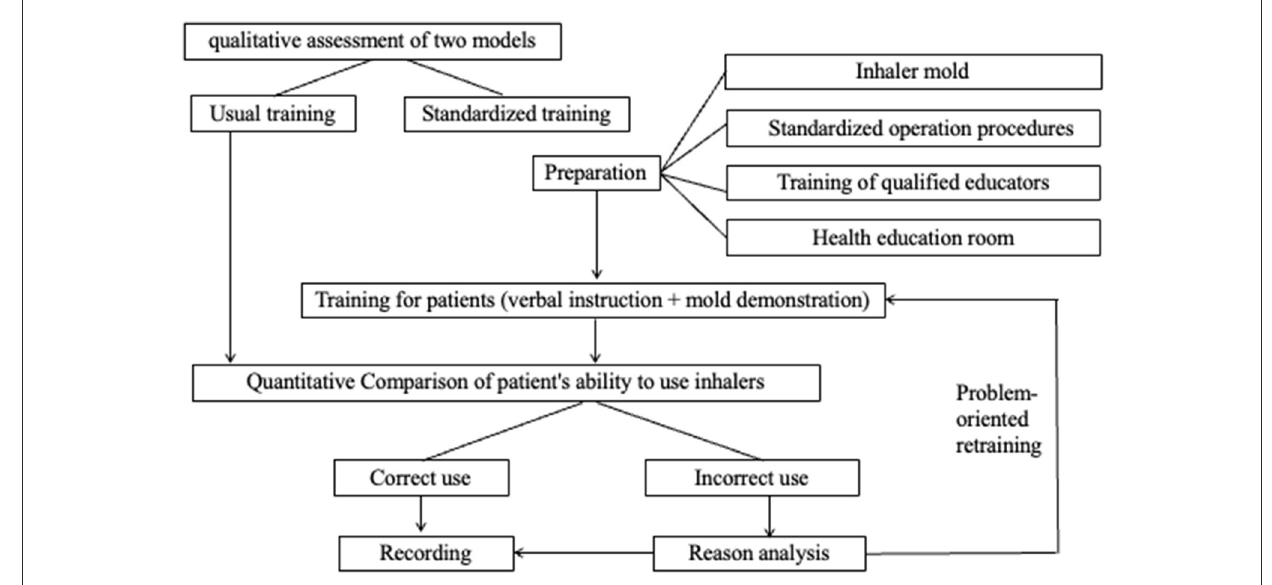
FIGURE1 Flow chart of standardized training